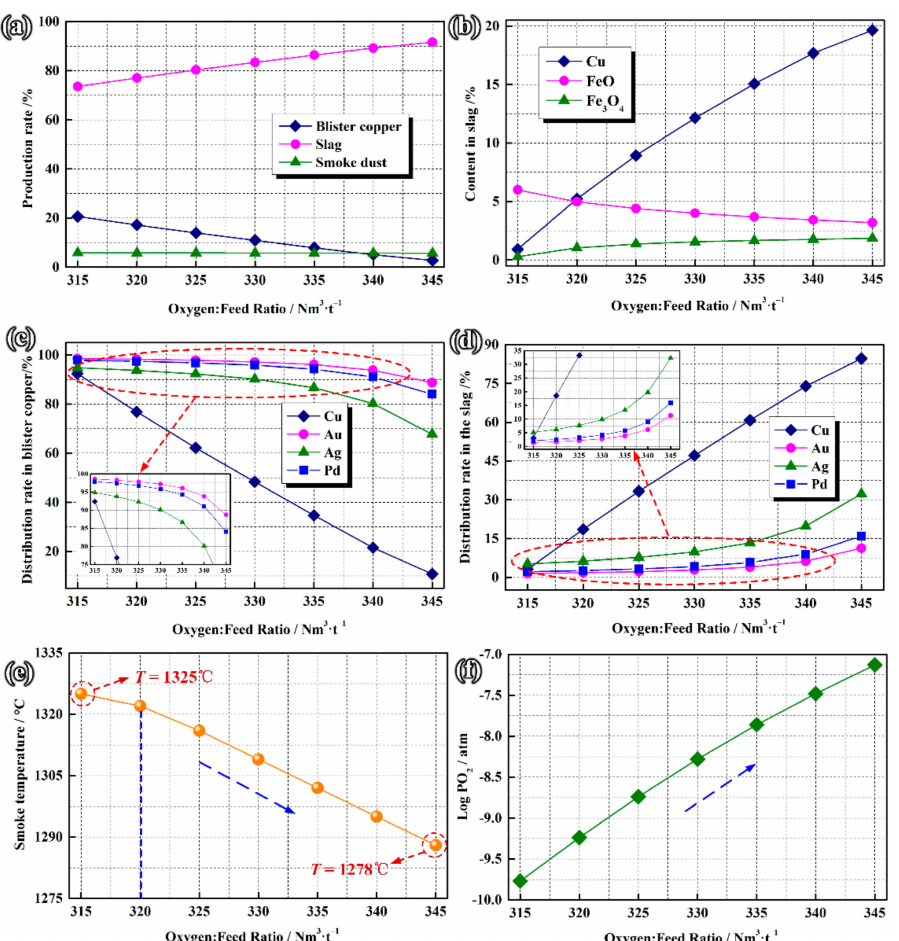
Figure 4. The influence of various oxygen:feed ratios on the top-blowing smelting of electronic waste. ( a ) Production rate of blister copper, slag and smoke dust; ( b ) content in slag; ( c ) distribution rate of various metals in blister copper; ( d ) distribution rate of different metals in the slag; ( e ) smoke temperature; ( f ) relationship between the oxygen potential (Log PO 2 ) and oxygen:feed